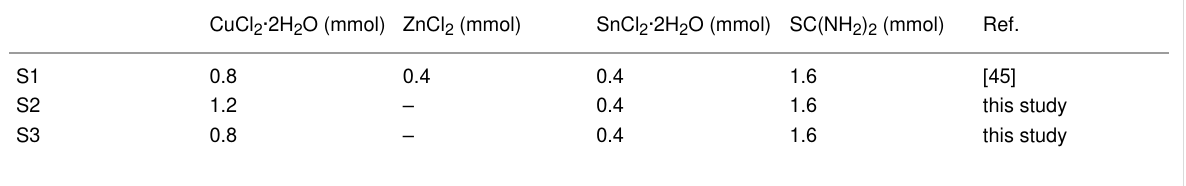
Table 1: Molar amounts of precursors dissolved in 50 mL of ethylene glycol